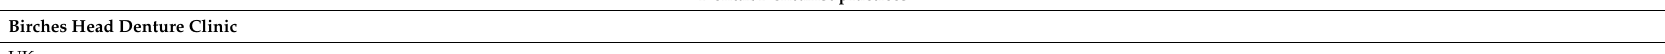
Dental/Denturist